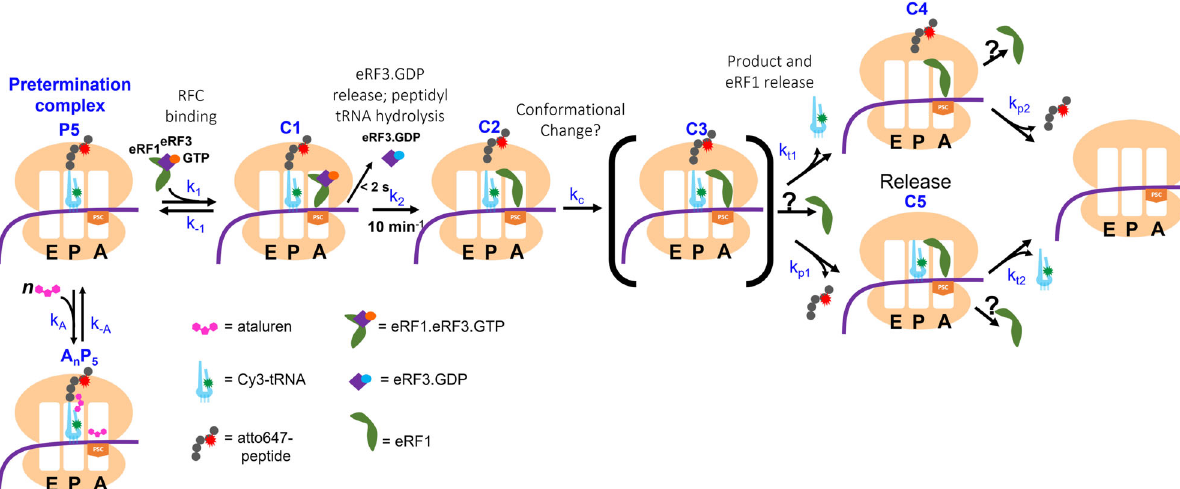
Fig. 6 A simpli fi ed model for RFC catalysis of termination. This model, consistent with all of our results, as well as with recent published results of others 37 , posits that ataluren inhibition results from the cooperative binding of ( n ) molecules of ataluren to the pretermination complex P5 in competition with RFC binding. It also invokes a hypothetical complex C3 resulting from an at least partial rate-determining conformational change, following cleavage of the tRNA-peptide ester bond to account for the similarity in the rate constants of tRNA, peptide, and eRF1 release (see text). The question marks associated with possible eRF1 release are shown to indicate our current uncertainty as to whether eRF1 release is coordinated with either peptide or tRNA release, or proceeds independently of